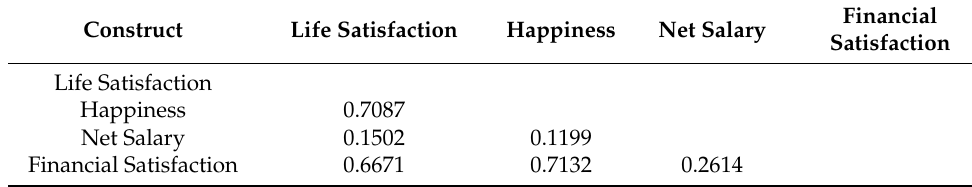
Table 3. Discriminant validity—heterotrait-monotrait ratio of correlations